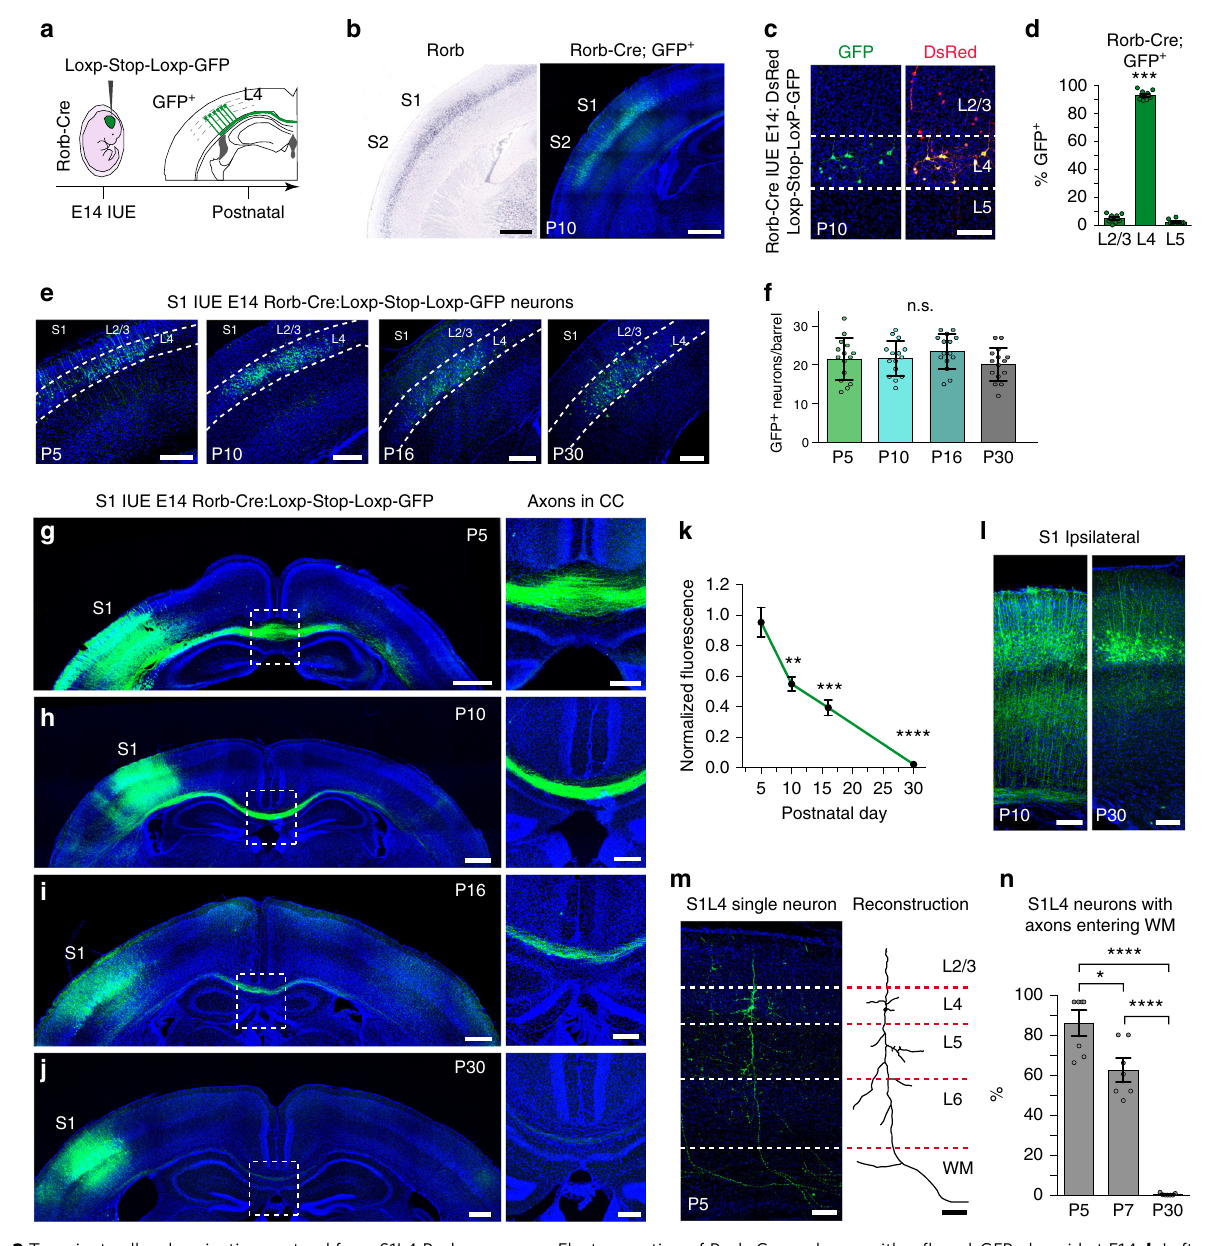
Fig. 3 Transient callosal projections extend from S1L4 Rorb neurons. a Electroporation of Rorb-Cre embryos with a fl oxed-GFP plasmid at E14. b Left panel, expression of endogenous Rorb expression (Image credit: Allen Institute). Right panel, GFP (green) in a P10 Rorb-Cre animal electroporated at E14 in S1